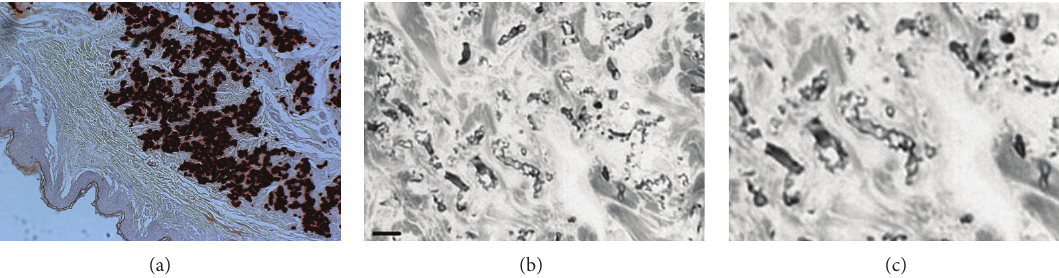
F 2: �istological characteristics of PXE skin lesions with fragmentation and calci�cation of middermal elastic �bers on Alizarin Red �taining (a). Electronmicroscopy reveals fragmentation of elastic �bers (b) with the calci�cation being present in the core of the elastic �ber (c).